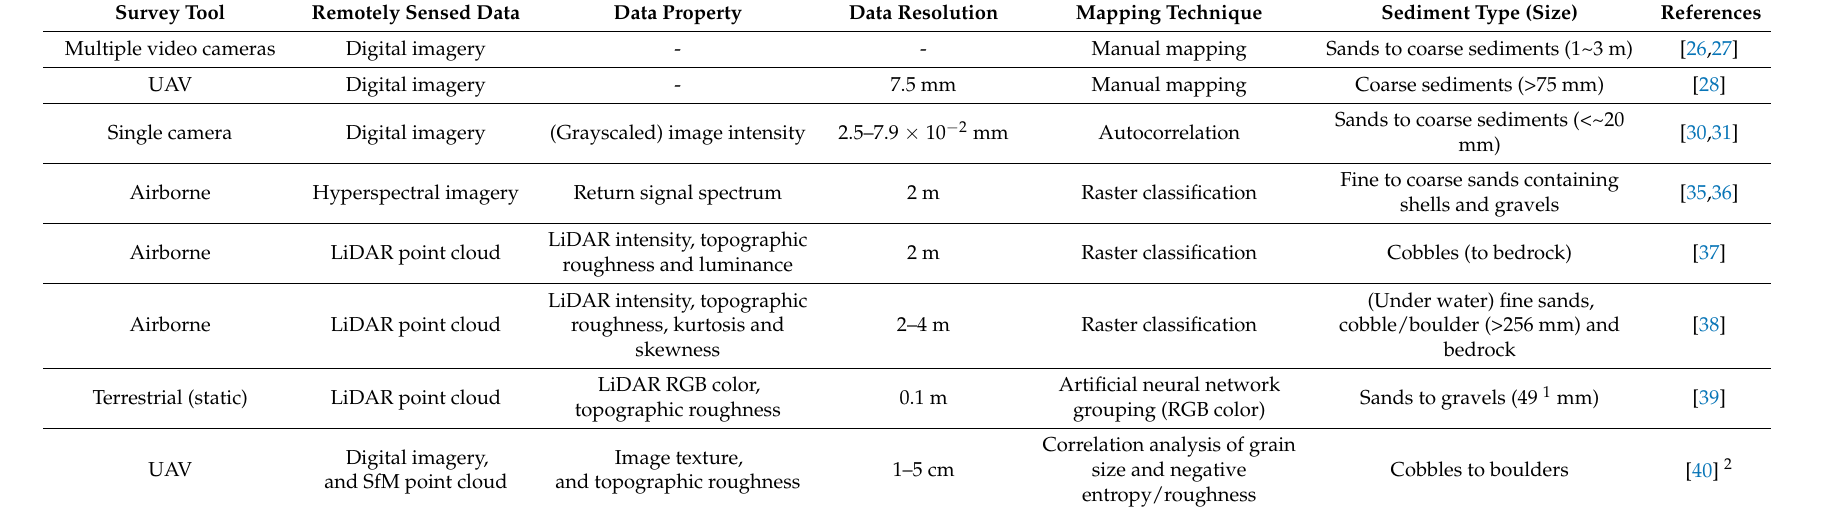
Table 1. Examples of remotely-sensed beach sedimentary mapping techniques. Sediment sizes (larger than sands) are shown where available. Survey